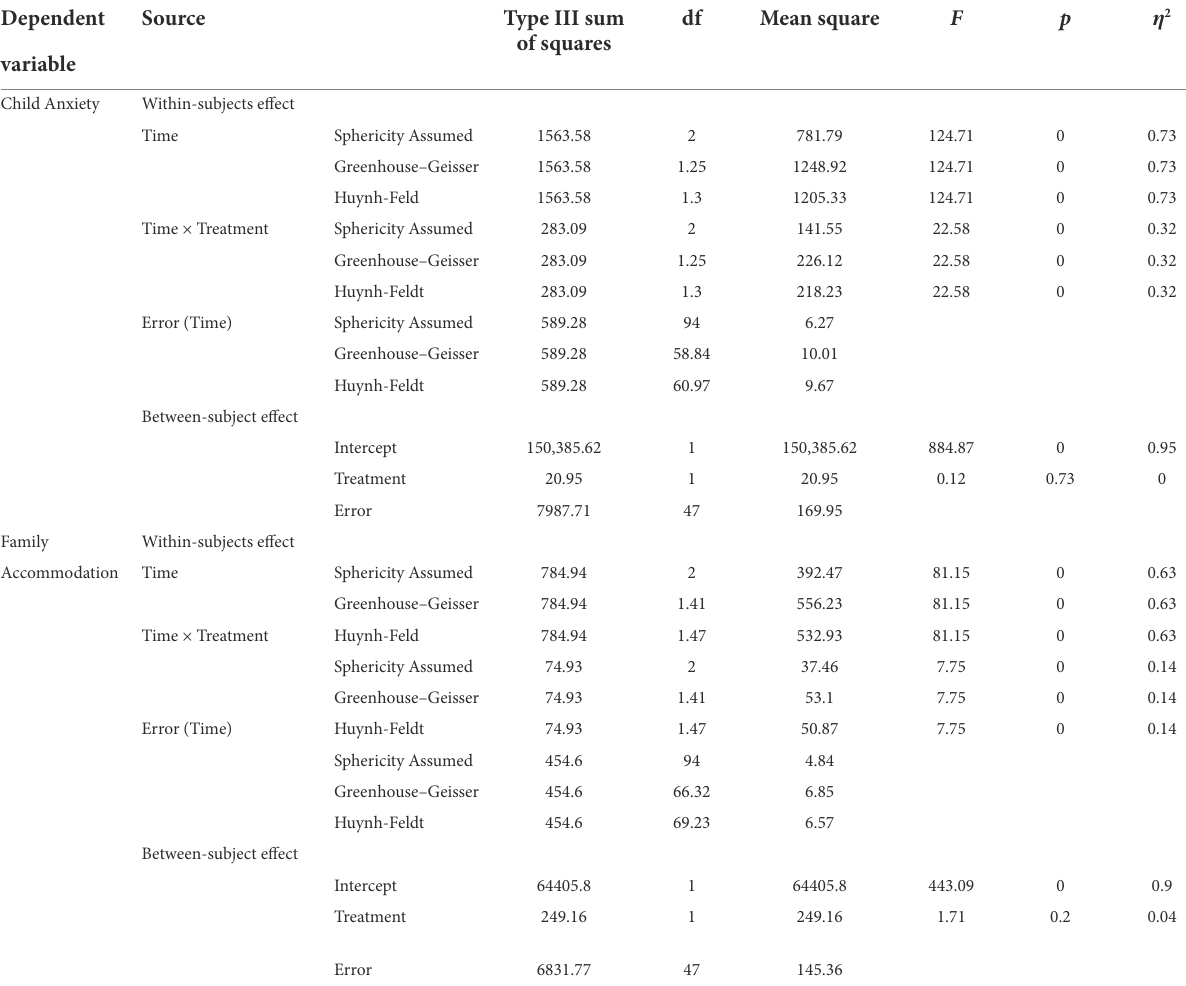
TABLE 7 The results of repeated measures